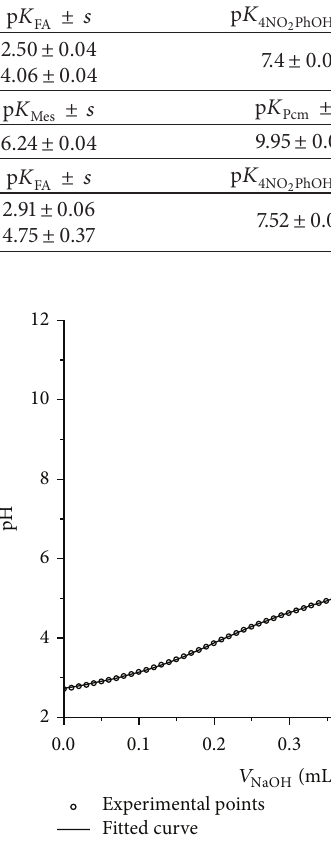
) obtained for NaOH